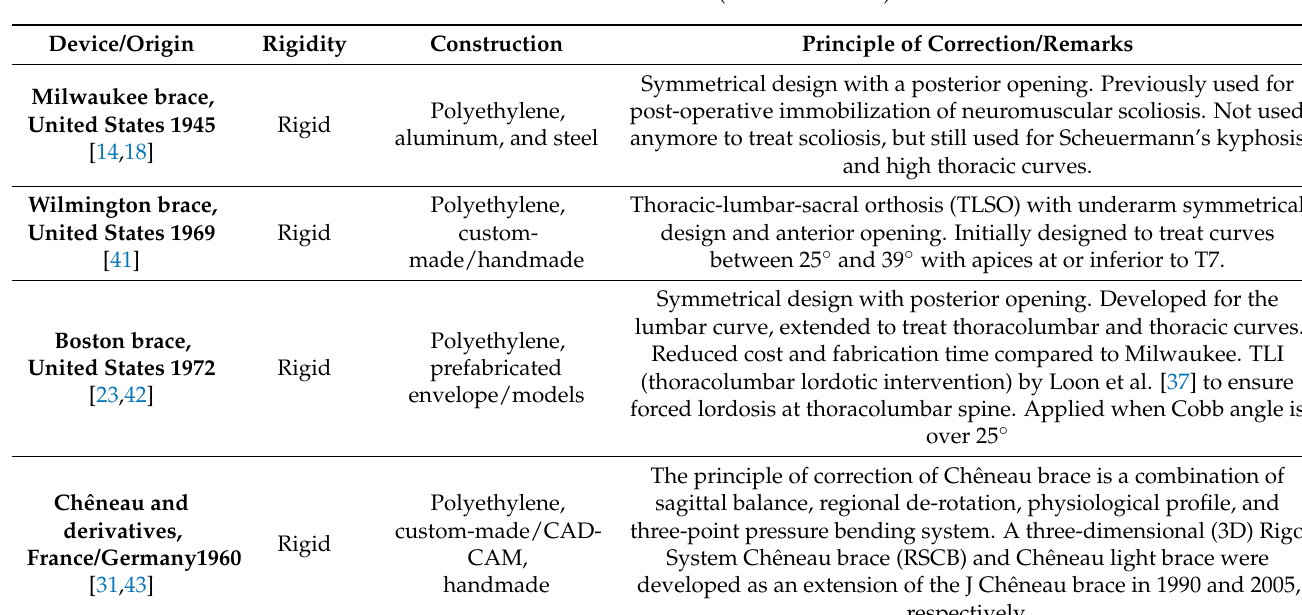
Figure 2. Rigid and soft corrective orthoses. Table 1. Corrective orthoses (braces and suits).